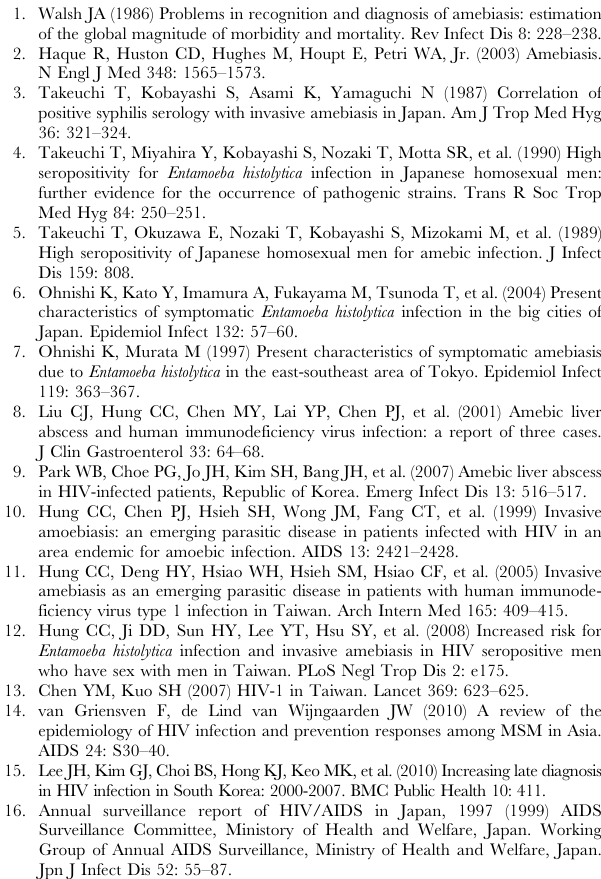
DNA reorganization events in organ tropism. PLoS Negl Trop Dis 2: